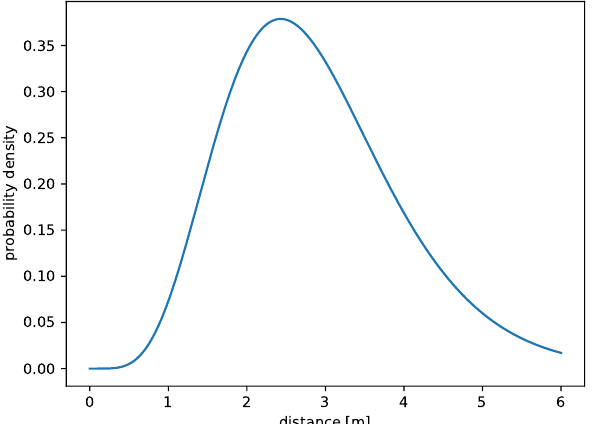
Figure 4. Gamma distribution ( 6.48936,0.44277 ) representing errors of a method based on Bluetooth Low-Energy (BLE)